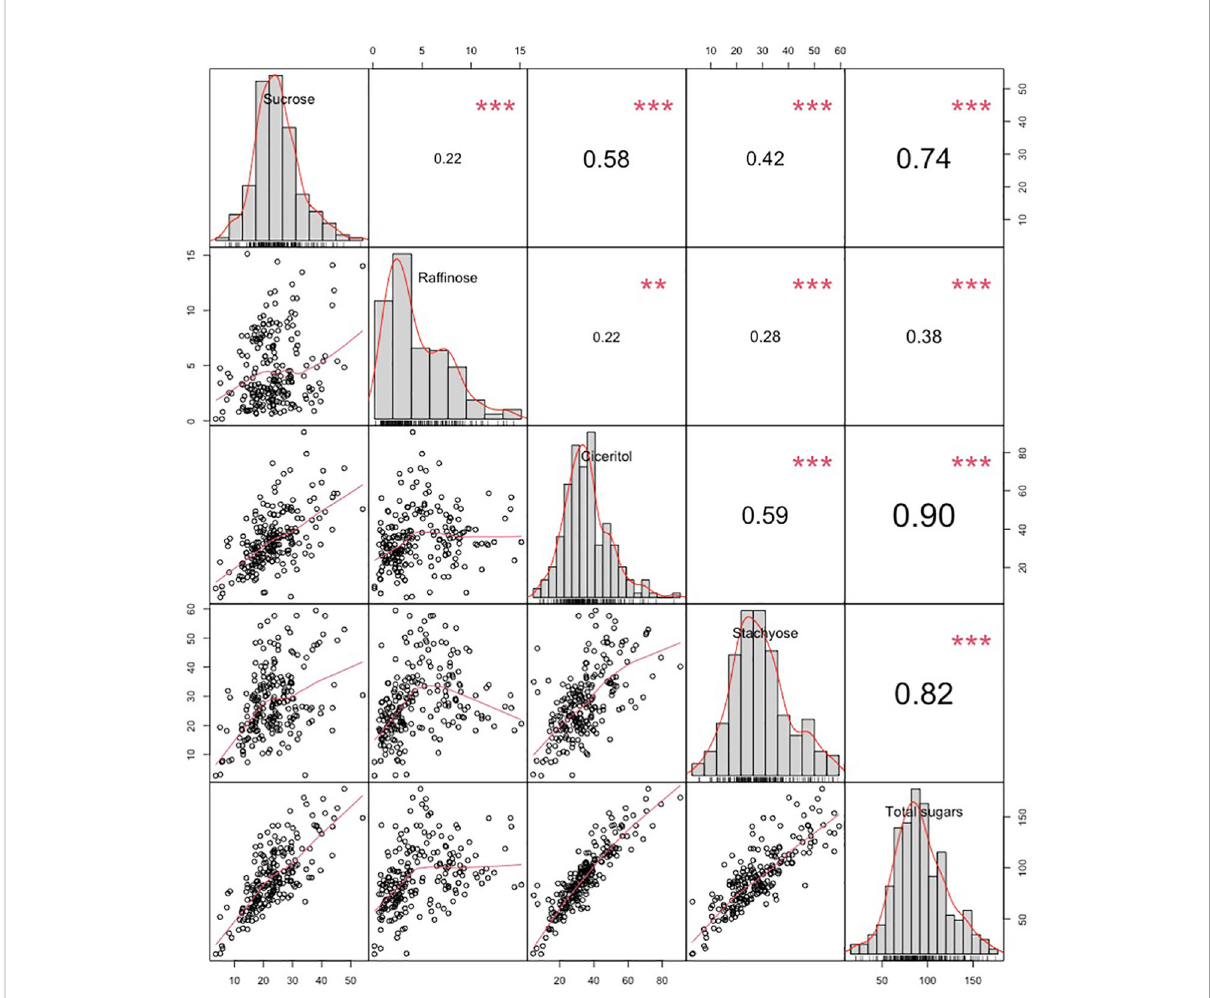
FIGURE 2 Variation and Pearson pairwise correlations of sucrose, raf fi nose, ciceritol, stachyose, and total sugars in chickpea. Upper diagonal: Pearson correlation coef fi cients between every two traits. Mid-diagonal: Histograms of sucrose, raf fi nose, ciceritol, stachyose, and total sugars. Lower diagonal: Bivariate scatter plots of correlations between every two traits with a fi tted line. **Signi fi cant at the .01 probability level. ***Signi fi cant at the .001 probability